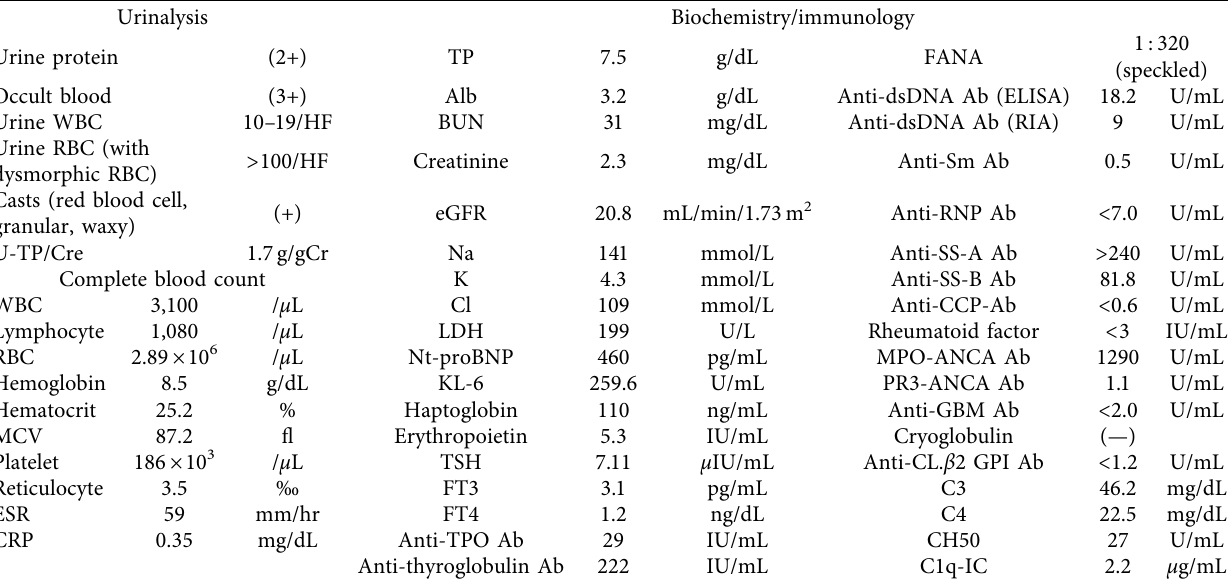
Figure 1: Skin lesions in this case. Purpura scattering on the legs (a) and magnified image of the purpura (b). Examination of punch biopsy specimen from the left lower leg (c, d) showing infiltration of inflammatory cells including neutrophils around small vessels in the dermis, which is consistent with leukocytoclastic vasculitis (hematoxylin-eosin stain). Immunofluorescence showing poor immune complex deposition ((e) IgM; (f) C3c). Table 1: Laboratory results of this